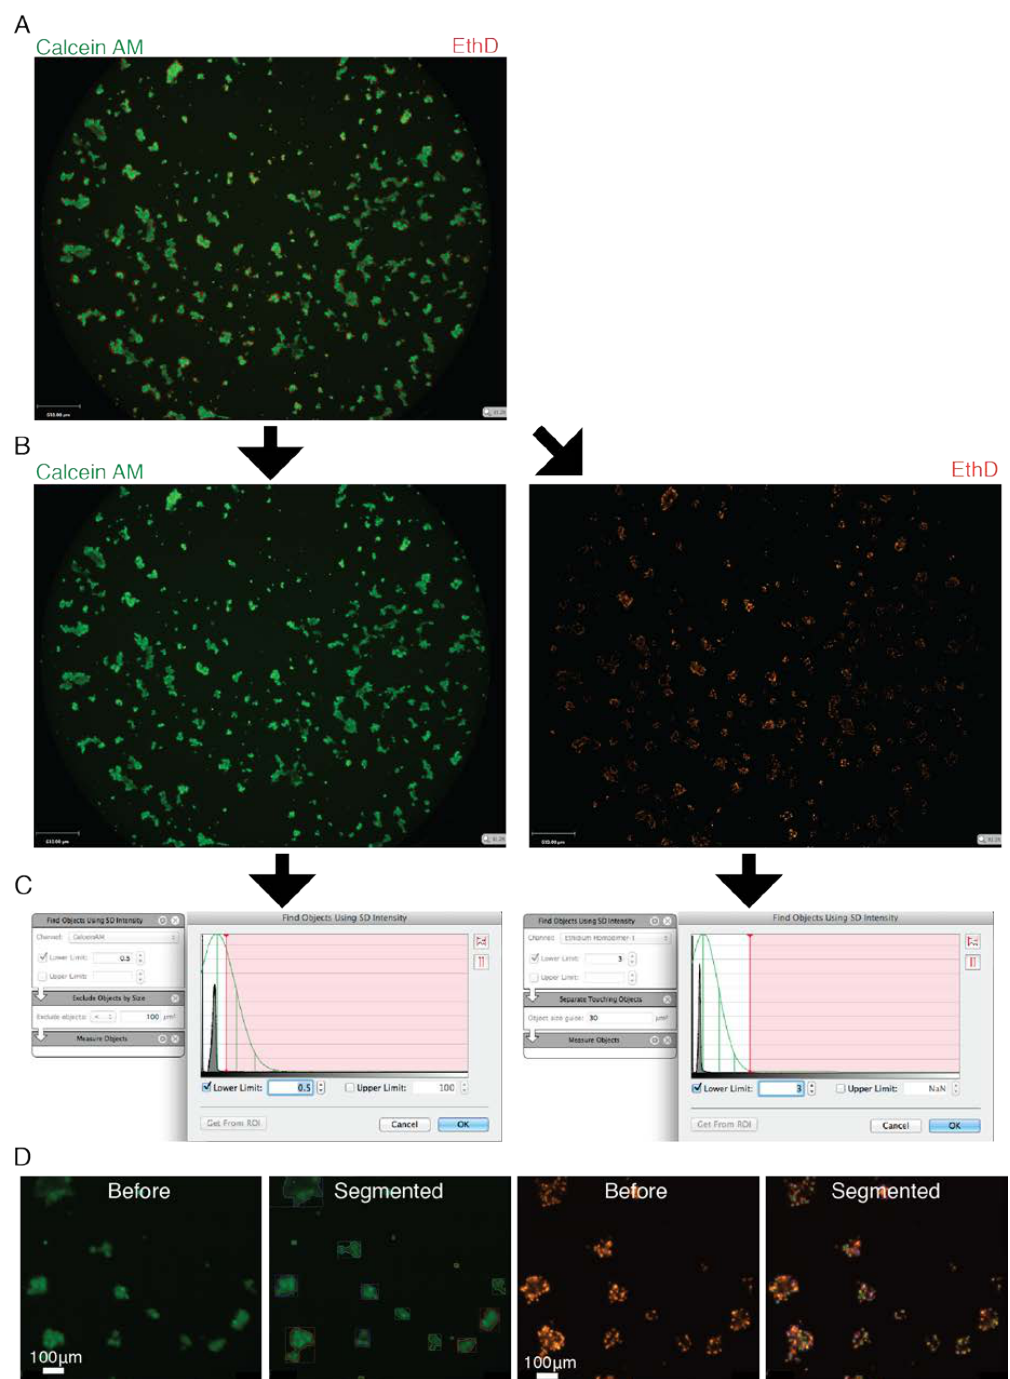
Figure A3. Fluorescent Microscopy Images of Entire Wells Containing Cells Stained with Live/Dead Stain Demonstrating a Simplified Breakdown of the Analysis. ( A ) Calcein AM stains the cells or clusters of cells green while EthD stains the dead cells red. ( B ) Green and red colour channels are separated. ( C ) A frequency plot shows the pixel counts (Y-axis) as a function of shade of grey (dark left, bright right, X-axis). A peak is usually seen indicating the shade of grey with the maximum number of pixels. From this graph the algorithm starts. First, from this maximum shade of grey peak, the user sets how many standard deviations (Green lines) away from this peak he wishes to set the threshold. After this initial threshold, post-processing steps are used to further separate objects or to select objects by size. ( D ) Examples are shown on how the algorithm detects either the Calcein AM or the EthD signals before (left) and after (right) algorithm